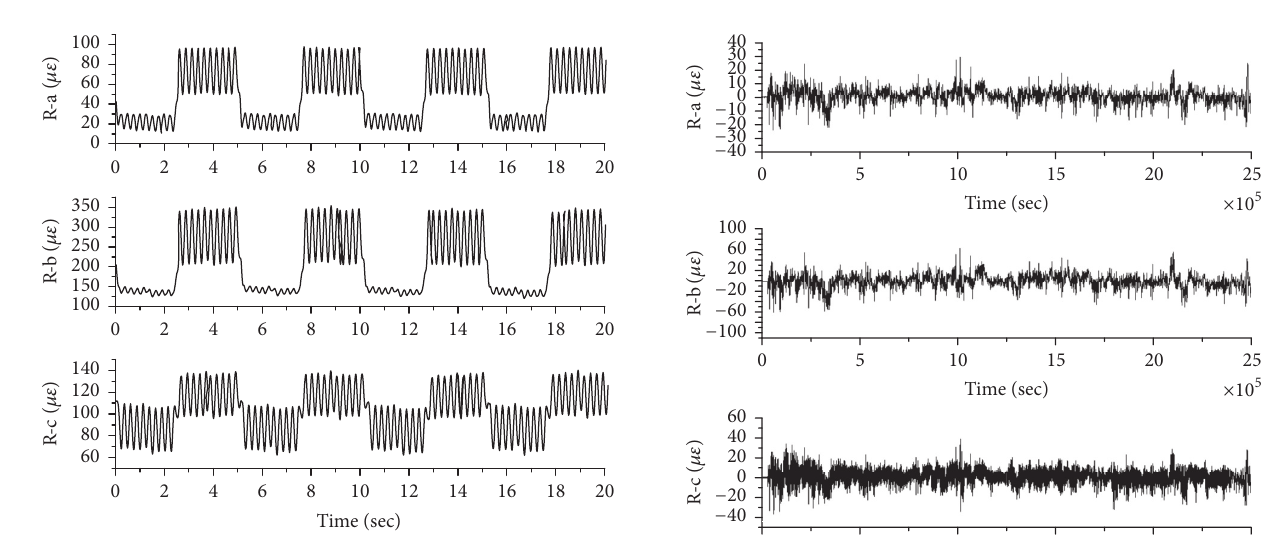
Figure 11: Strain occurring in fatigue test (Point 1).